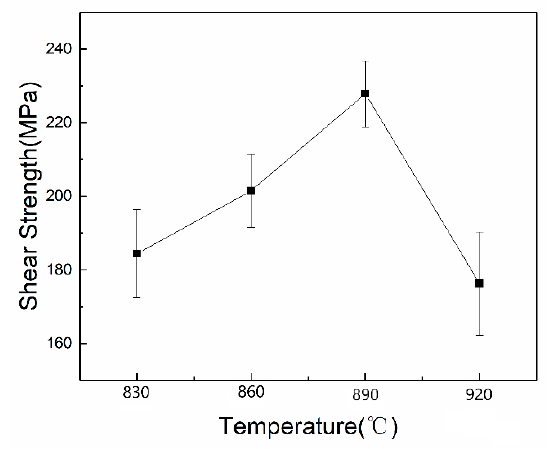
Figure 10. Shear strength of coatings at different temperatures.